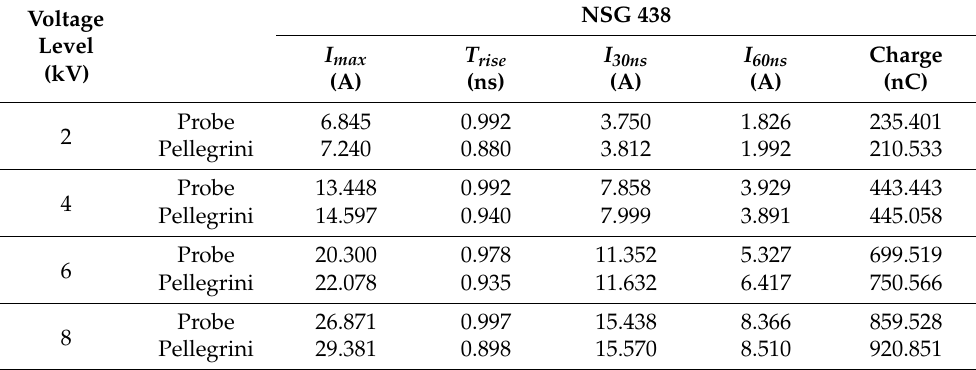
Table 5. Reconstructed and reference ESD current parameters the Schaffner NSG 438 ESD